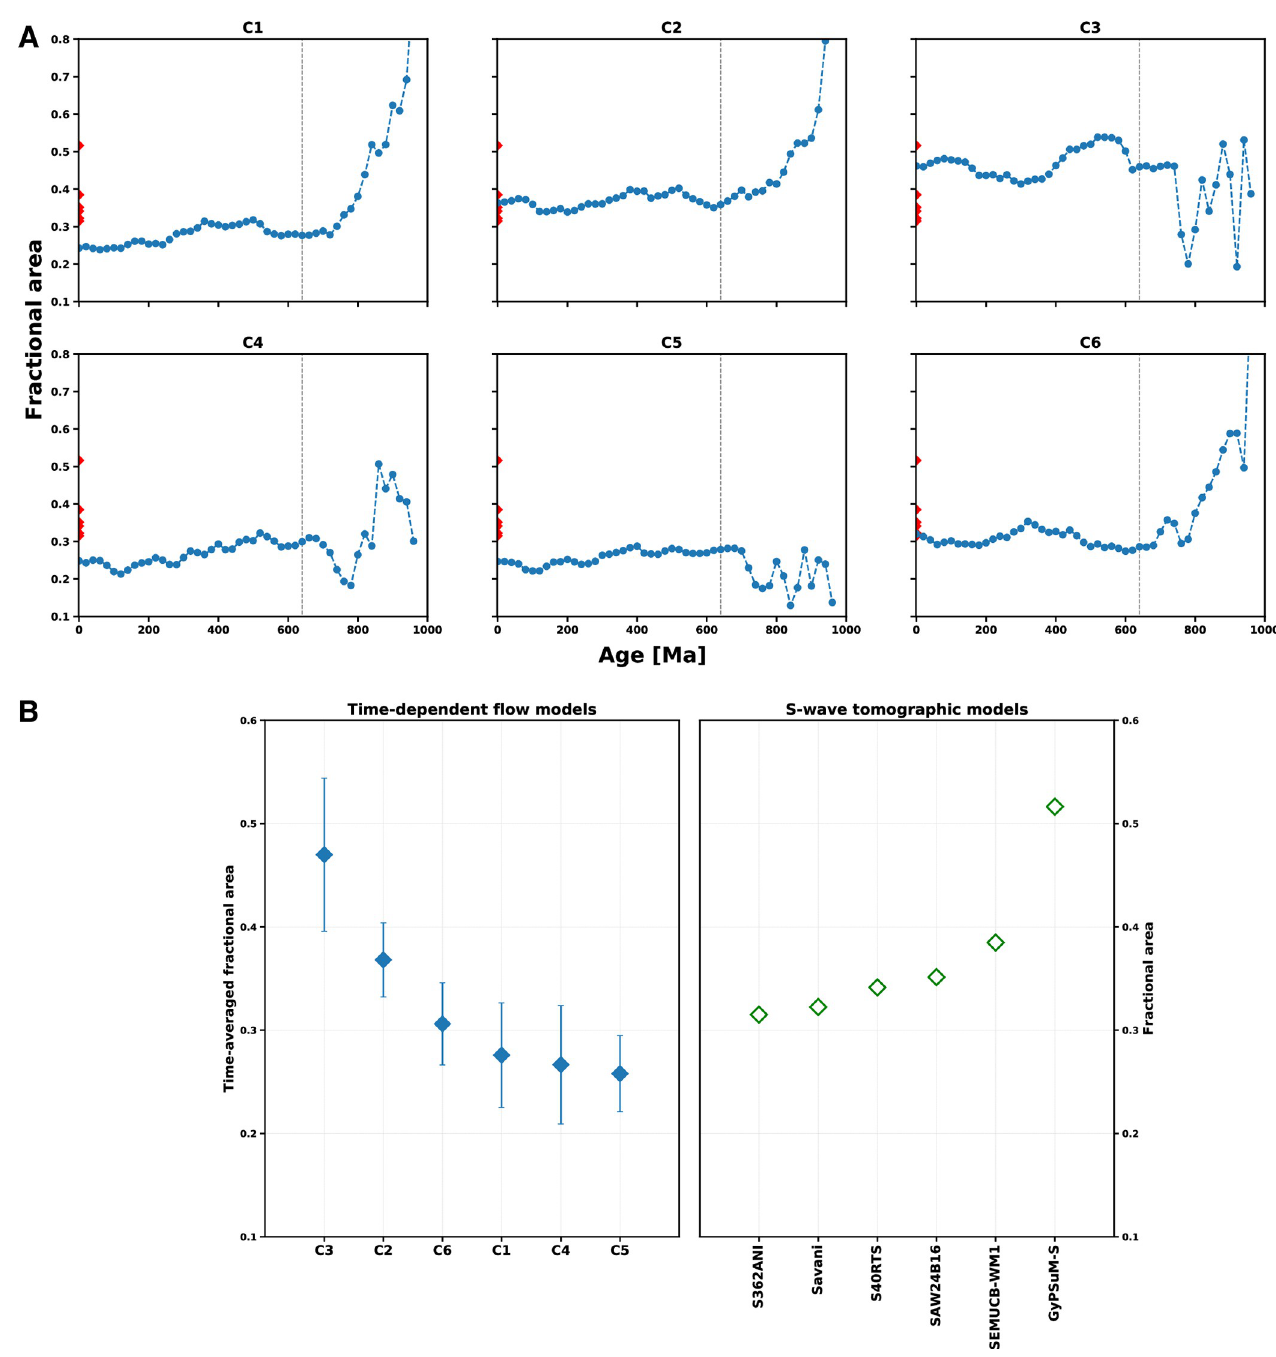
Fig 5. Fractional area covered by hot/slow basal mantle structures in mantle flow and tomographic models. A/ Evolution of the fractional area of basal mantle structures f a in flow models (blue circles and lines) and for tomographic models (red diamonds at present-day). The dashed vertical line is at 640 Ma. B/ � , blue diamonds with standard deviation shown as error bars on the left-hand-side panel, Fractional area of basal mantle structures averaged from 640 Ma ( � f a � ), compared to present-day f sorted by decreasing � f a for tomographic models (open green diamonds on the right-hand-side panel, sorted by increasing f a ). a